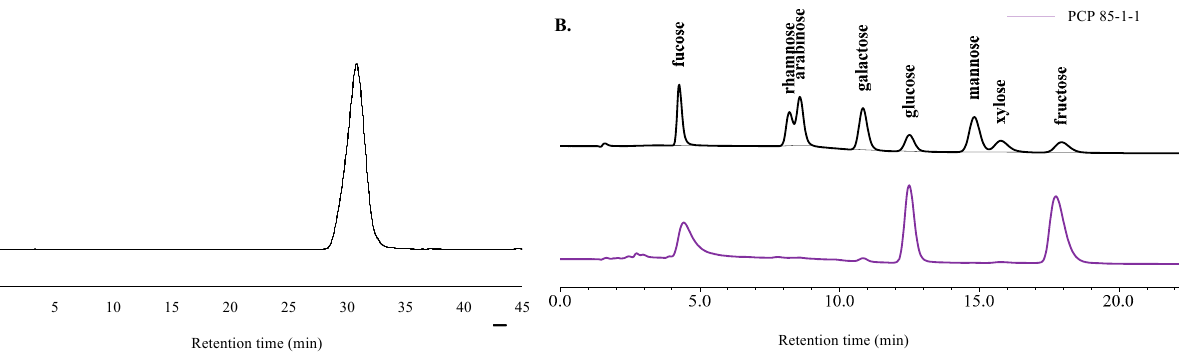
Figure 3. ( A ) The HPGPC-RID profiles of PCP 85 − 1 − 1; ( B ) HPLC-RID chromatograms of standard monosaccharide mixture and hydrolysis products of PCP 85 − 1 − 1.